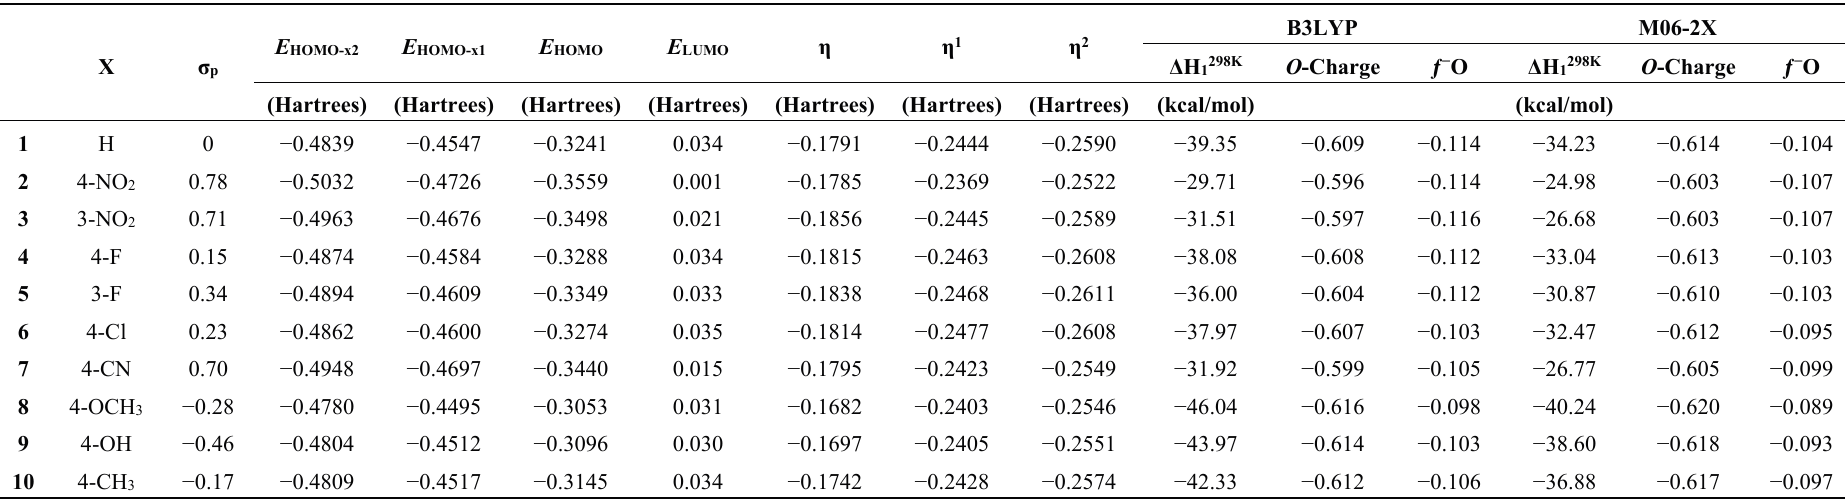
Table 1. Calculated properties for the 4- or 3-X-cinnamic acids: Hammett substituent constants ( σ p ), molecular orbital energies (in hartrees), hardness parameters ( η , η 1 and η 2 , in hartrees), standard enthalpy variation (first step, in kcal/mol), atomic charges and ƒ − O Fukui function. B3LYP and M06-2X results are both given for comparison.